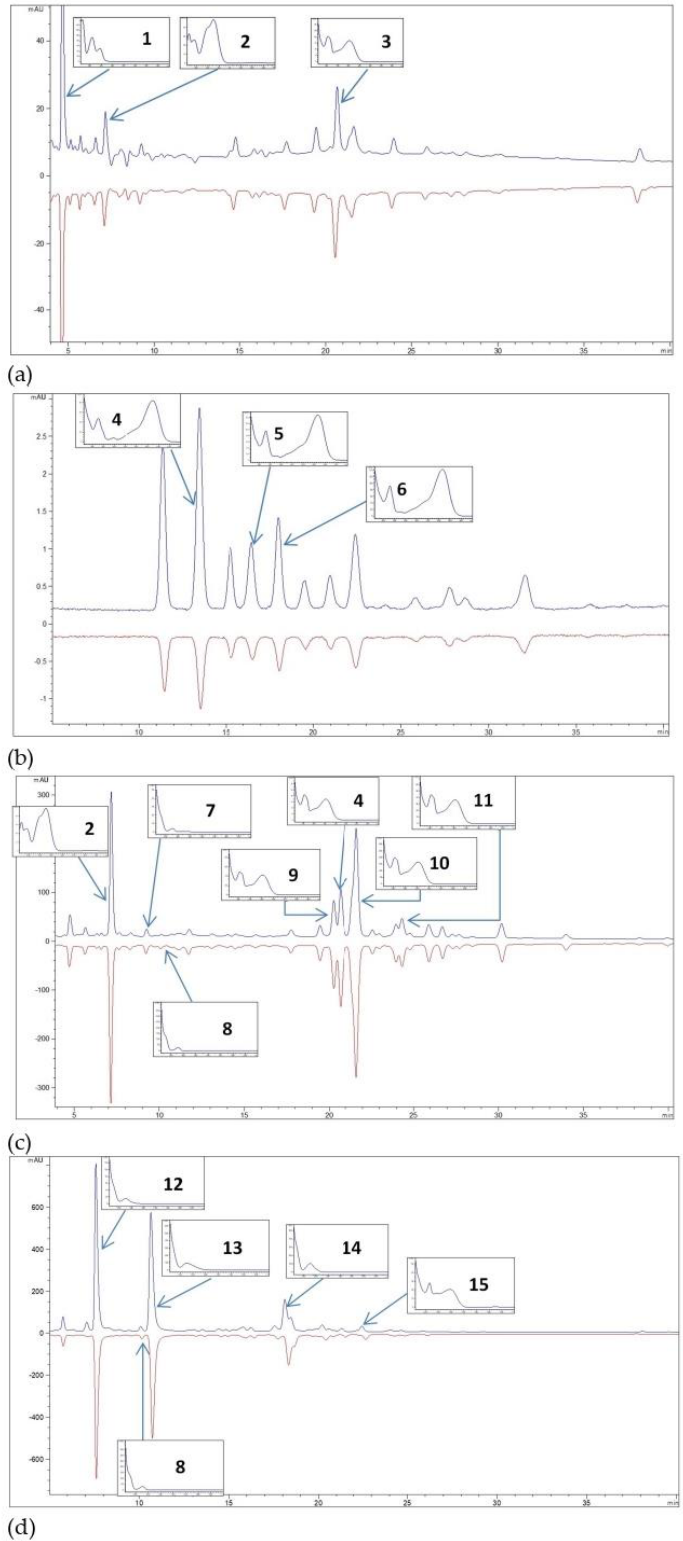
Figure 3. Representative examples of HPLC chromatograms of extracts obtained using NaDES − malic acid + glycerol (blue colour) and ethanol (red colour) of ( a ) bilberry fruit, polyphenol compounds profile ( 1 , protocatechuic acid; 2 , chlorogenic acid; 3 , hyperoside); ( a , b ) bilberry fruit, anthocyanins profile ( 4 , delphinidin − 3 − O − glucoside; 5 , cyanidin − 3 − O − galactoside; 6 ,